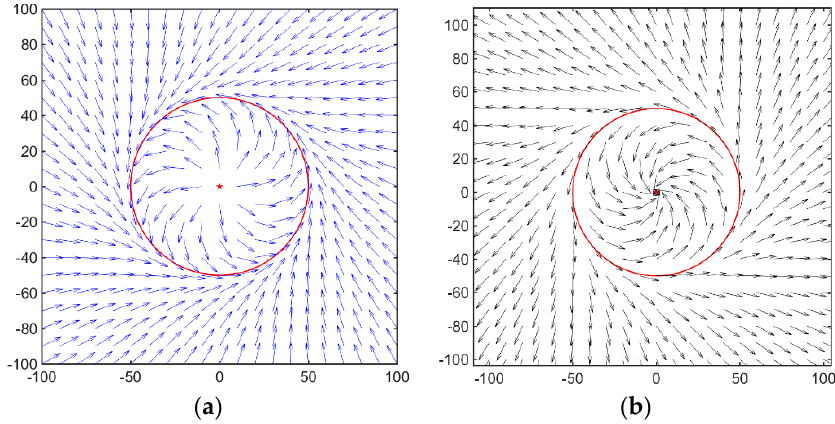
Figure 7. Lyapunov vector field and inverse Lyapunov vector field with rd = 50 m and c = 0.7. ( a ) Lyapunov vector field; ( b ) Inverse Lyapunov vector